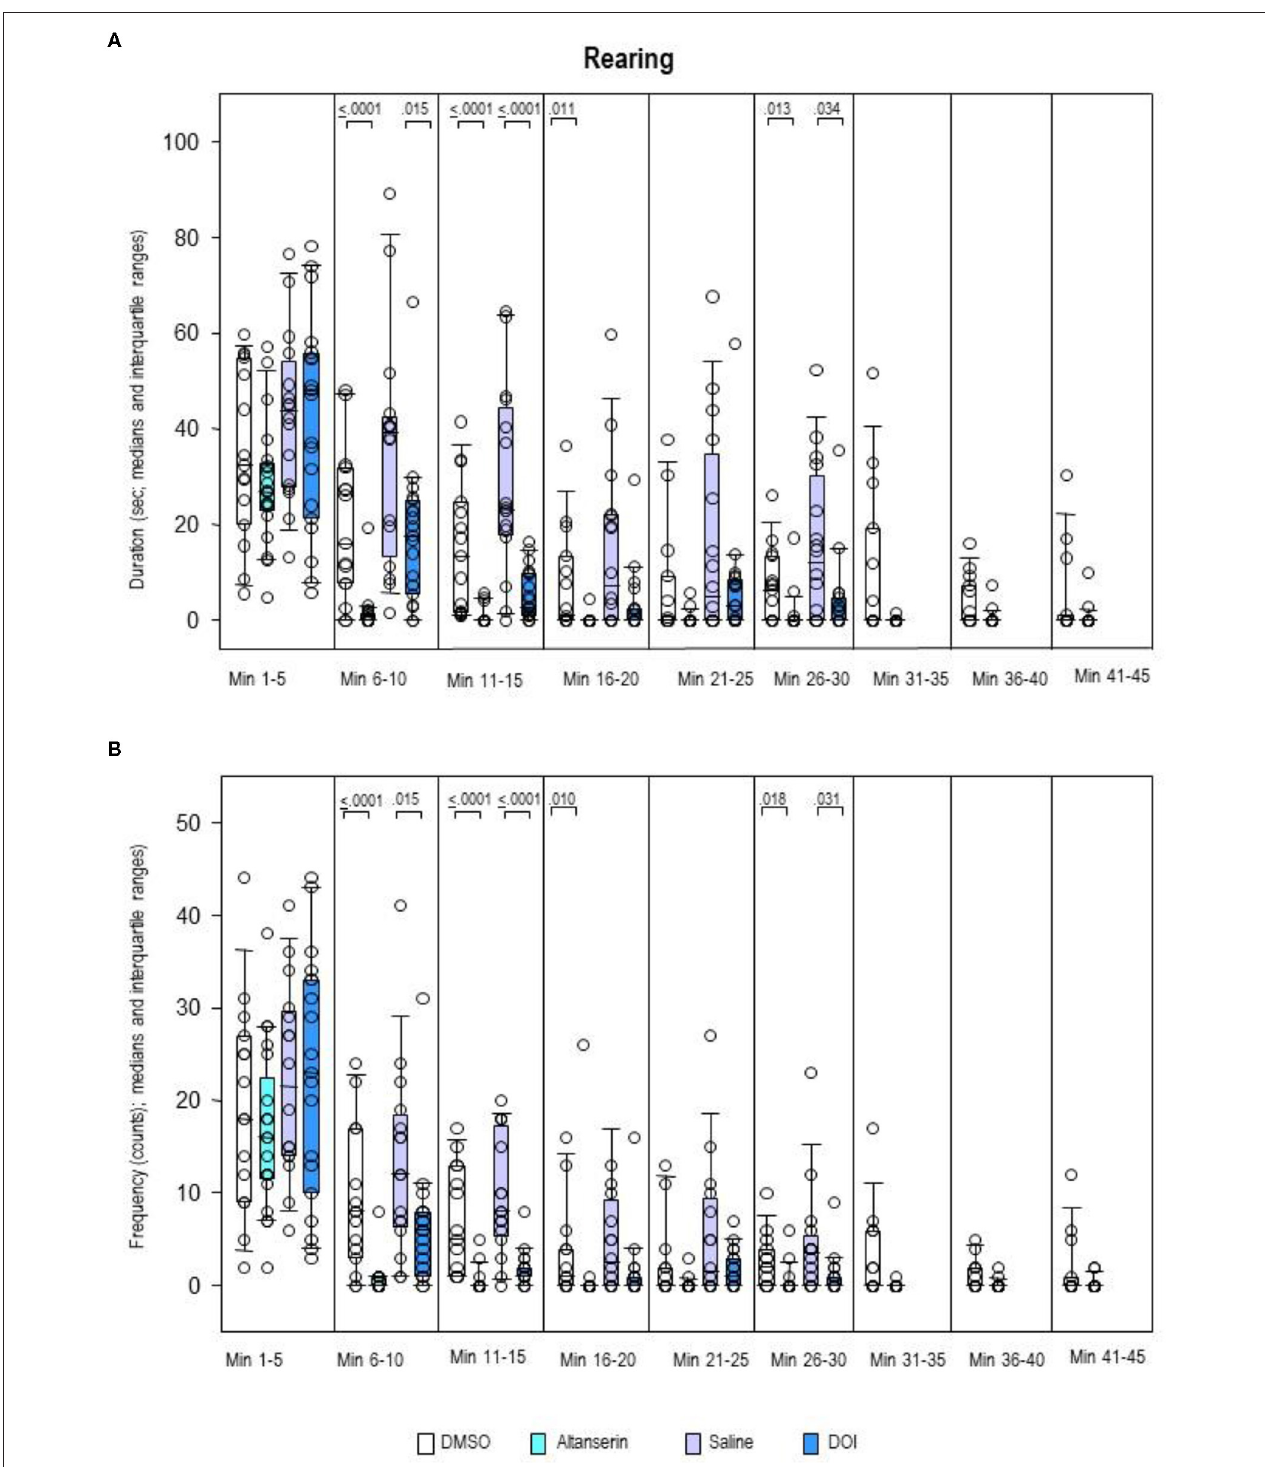
FIGURE 9 | Rearing. Duration (s) and frequency (counts) after 10 mg/kg of altanserin (turquoise), 0.5 mg/kg of 2,5-dimethoxy-4-iodoamphetamine (DOI; blue), and the respective vehicles [dimethyl sulfoxide (DMSO), white; saline, light purple]. The figure shows box and whisker plots of median rearing durations (A) and frequencies (B) in the individual 5-min bins. The 25th/75th percentiles are given in the boxes, while the 5th/95th percentiles are represented by the whiskers. The circles represent the individual animals. Groups (altanserin vs. DMSO; DOI vs. saline) were compared with the independent Mann–Whitney U -test (two-tailed, α = 0.05). Significant p -values are